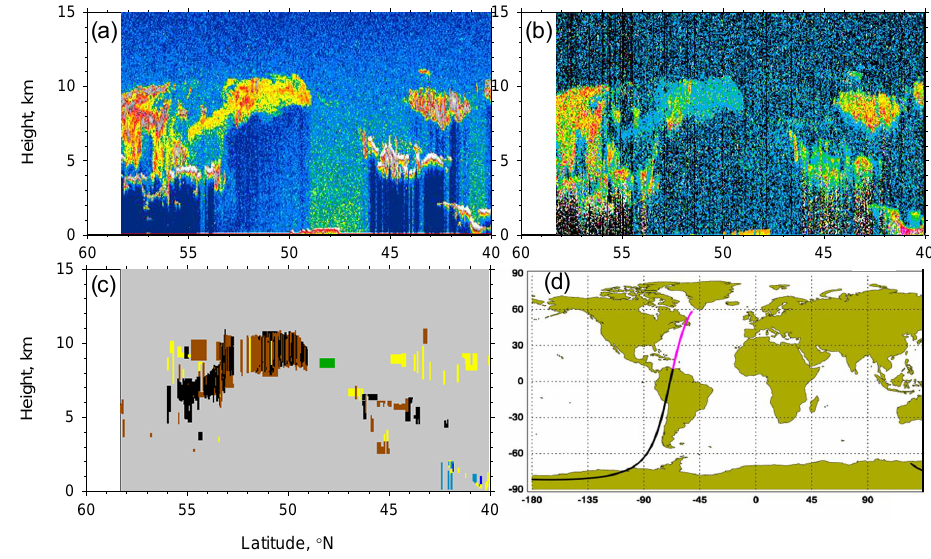
Figure 15. As Fig. 14 for a section of the CALIPSO orbit which passed over the Atlantic from 06:04 to 06:09UTC on 20 May 2016.